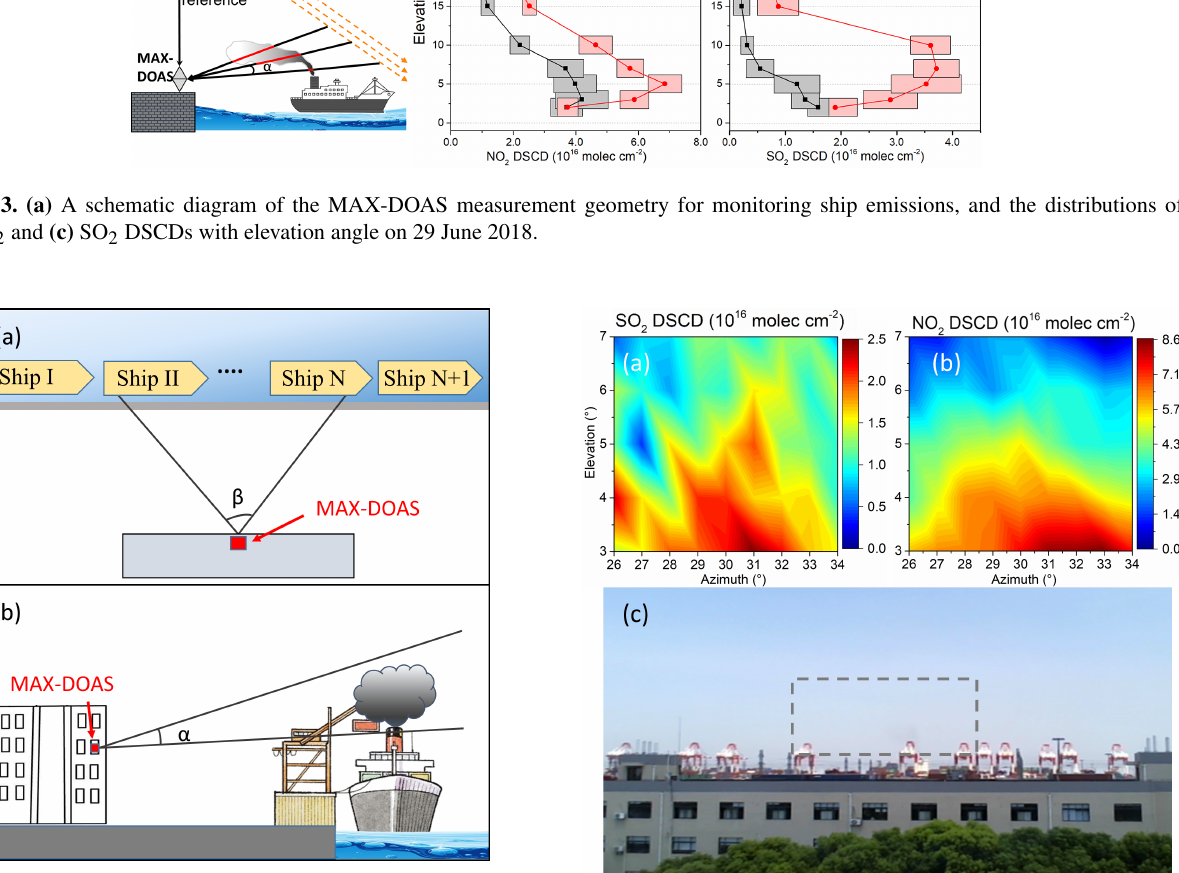
Figure 5. Distributions of the measured DSCDs of (a) SO 2 and (b) NO 2 from emissions of a ship at berth from 12:04 to 12:20 on 28 August 2017, and (c) a live photo captured by the MAX-DOAS instrument’s camera. The dashed rectangle indicates the observa- tional view of the